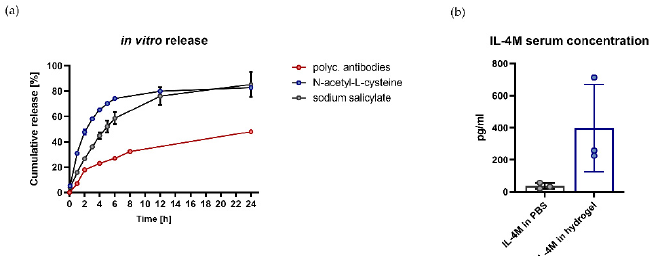
Figure 2. In vitro and in vivo release of bioactive compounds by hydrogel. ( a ) In vitro release of polyclonal anti-lysozyme antibodies, N-acetyl-cysteine, and sodium salicylate by hydrogel, analyzed over a period of 24 h. ( b ) Release of IL-4M administered systemically in PBS (i.p.) or locally (s.c.) in hydrogel. IL4-M concentration was analyzed in serum 24 h after injection ( n = 3).